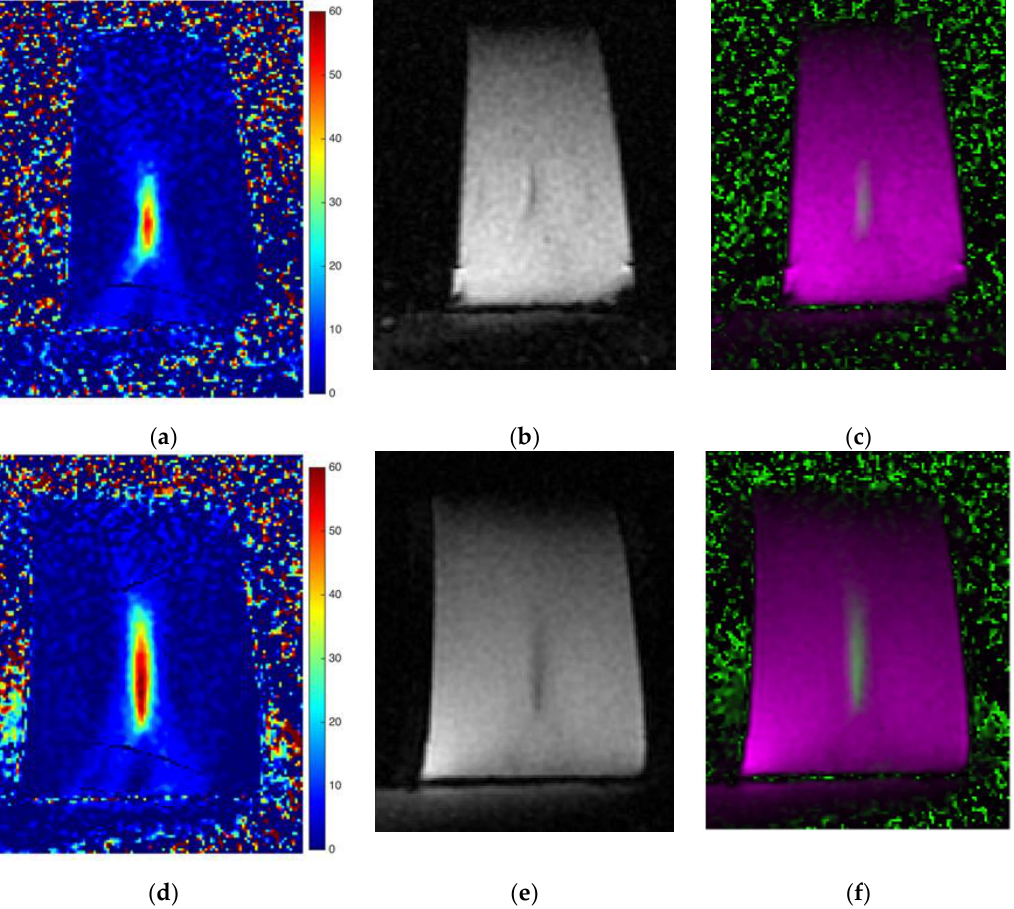
Figure 7. Sonications #4 (first row) and #5 (second row) morphological and thermal map examples: ( a ) and ( d ) temperature reconstruction; ( b ) and ( e ) morphological image; ( c ) and ( f ) temperature image overlapped on the morphological image. It is possible to estimate the noise in the gel pad and in the skin interface by observing the low SNR in those